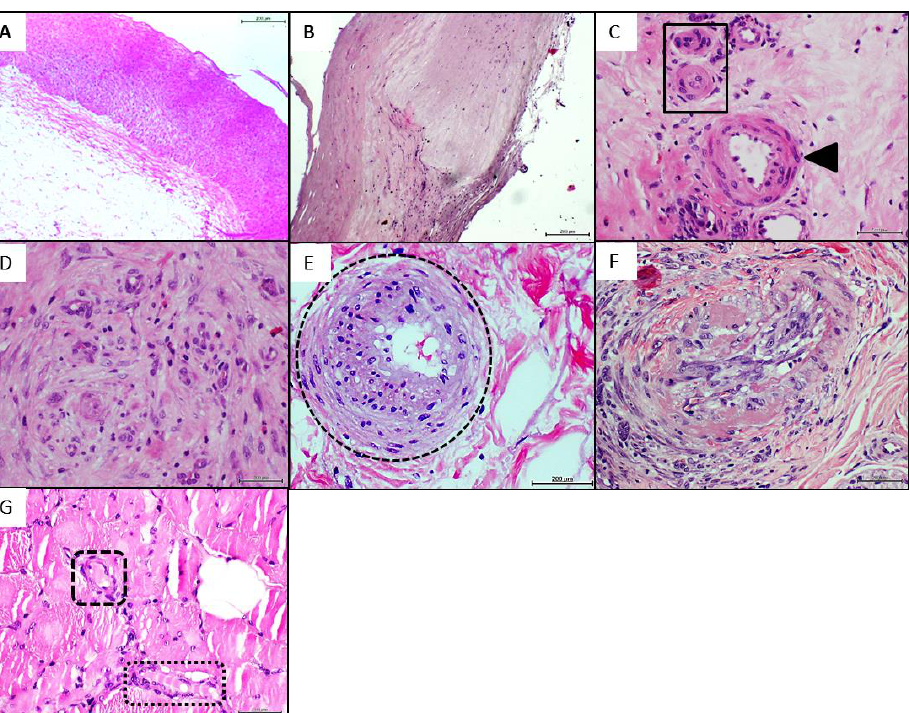
Figure 1. Histological characterization of human donors’ tissues by hematoxylin/eosin staining. ( A ): Fragment of the healthy donor brachial artery showing transmural preservation of the vascular wall. Magnification 10×. ( B ):